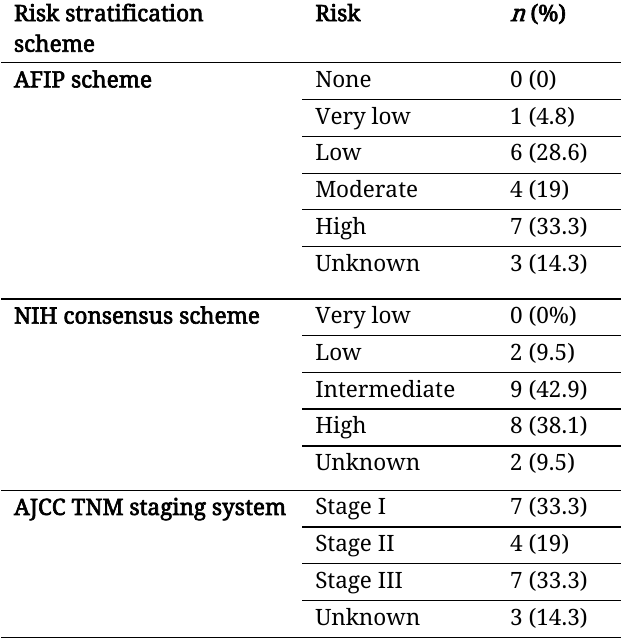
Figure 2: Kaplan-Meier overall survival curves according to the extent of disease at presentation Table 3: Risk stratification of 21 patients with non- metastatic GIST who achieved complete remission